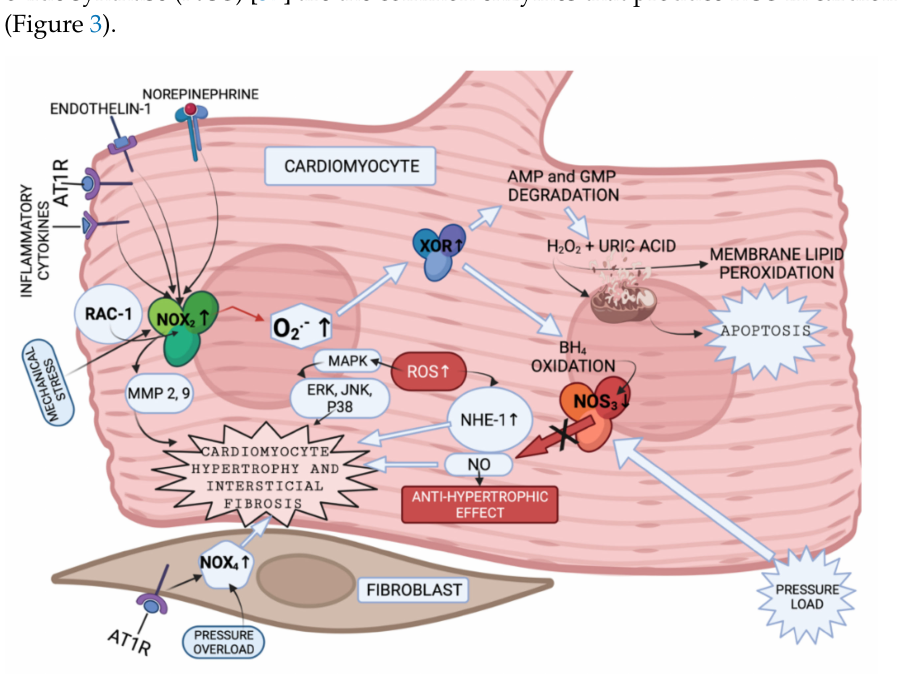
Figure 3. Enzymes involved in ROS production in cardiomyocytes and fibroblasts (created